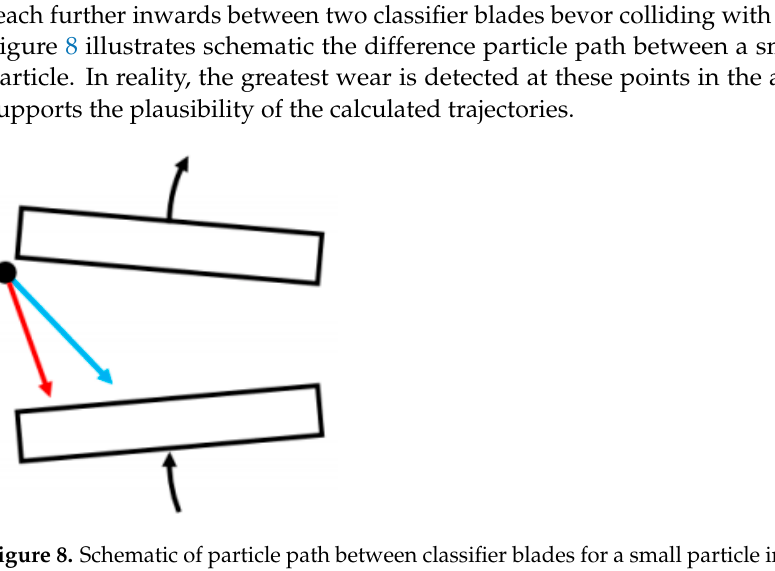
Figure 8. Schematic of particle path between classifier blades for a small particle in blue and a coarser particle in red.